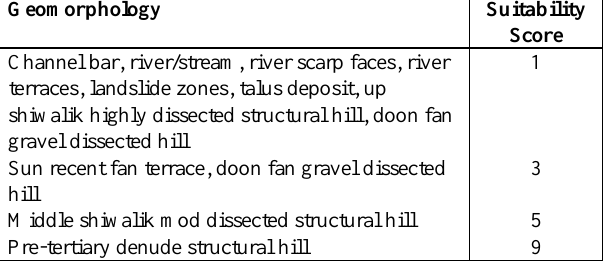
Table 5. Suitability Scores given for different geomorphology